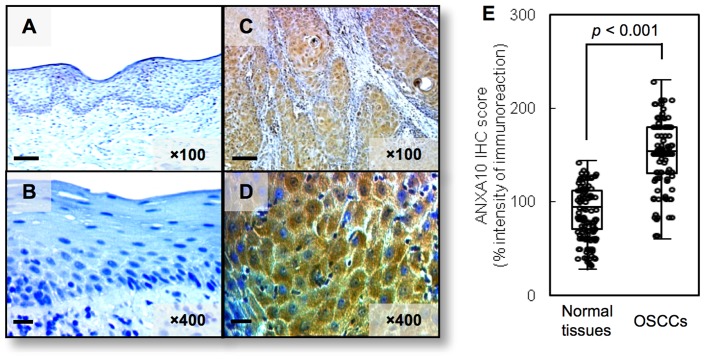
Evaluation of ANXA10 protein expression in primary OSCCs.Representative IHC results for ANXA10 protein in normal oral tissue (A, B) and primary OSCC (C, D) (A, C) Original magnification, ×100. Scale bars, 50 μm. (B, D) Original magnification, ×400. Scale bars, 10 μm). Strong ANXA10 immunoreactivity is detected in primary OSCCs; normal oral tissues show almost negative immunostaining. (E) The state of ANXA10 protein expression in primary OSCCs (n = 100) and the normal counterparts. The ANXA10 IHC scores are calculated as follows: IHC score  = 1× (number of weakly stained cells in the field) +2× (number of moderately stained cells in the field) +3× (number of intensely stained cells in the field). The ANXA10 IHC scores for normal oral tissues and OSCCs ranged from 27.5 to 132.4 (median, 93.5) and 60.5 to 230.4 (median, 150.6), respectively. ANXA10 protein expression levels in OSCCs are significantly (*p<0.001, Mann-Whitney's U test) higher than in normal oral tissues.